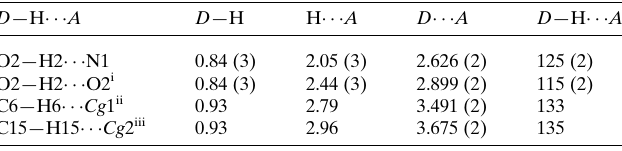
Table 1 Hydrogen-bond geometry (A˚ , (cid:3) ).